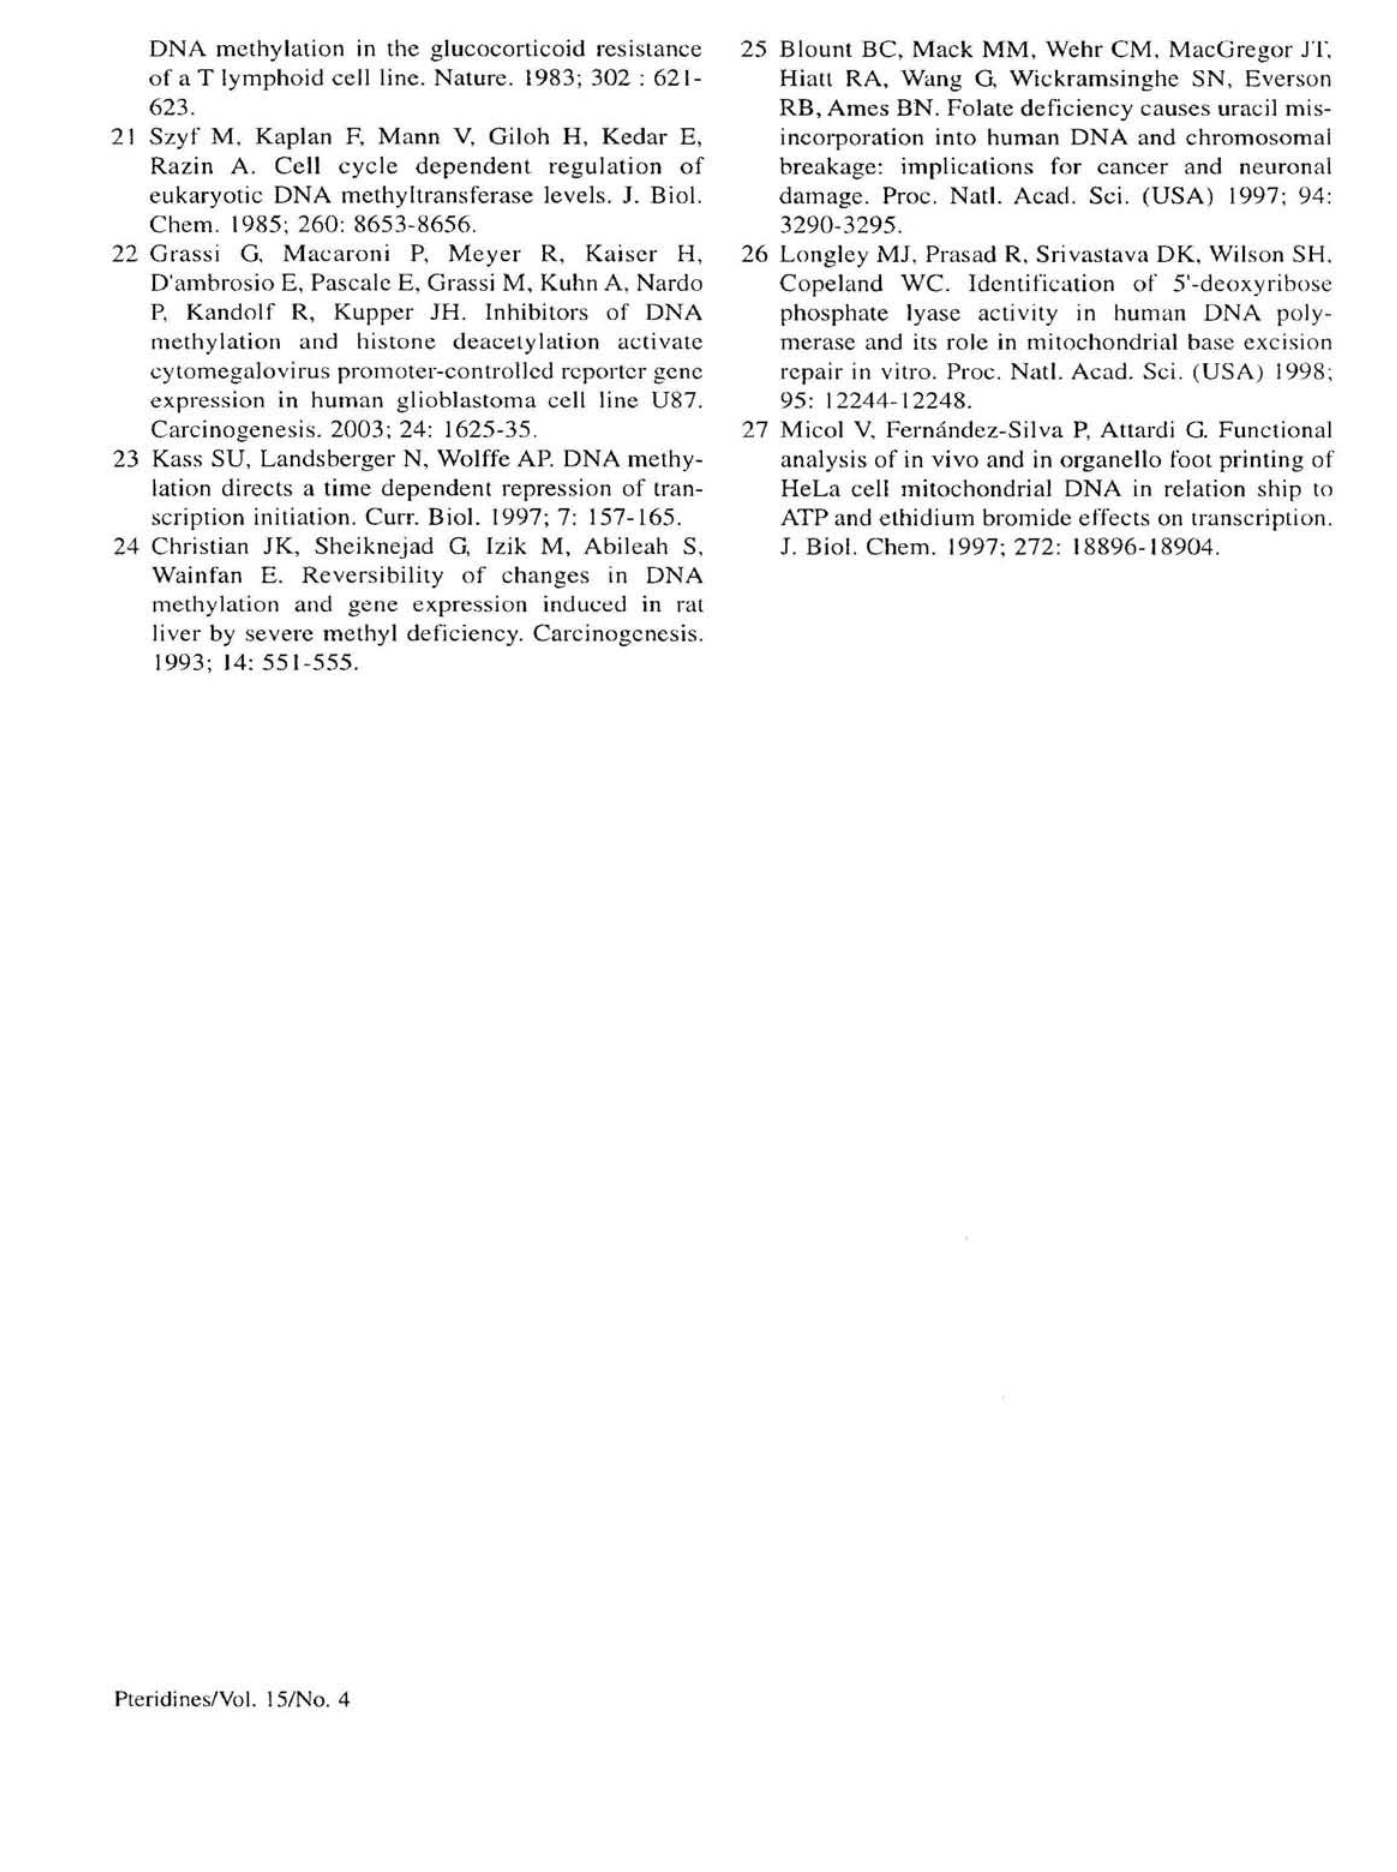
DNA methylation in the glucocorticoid resislance of a T lymphoid cell line. Nature. 1983; 302 :